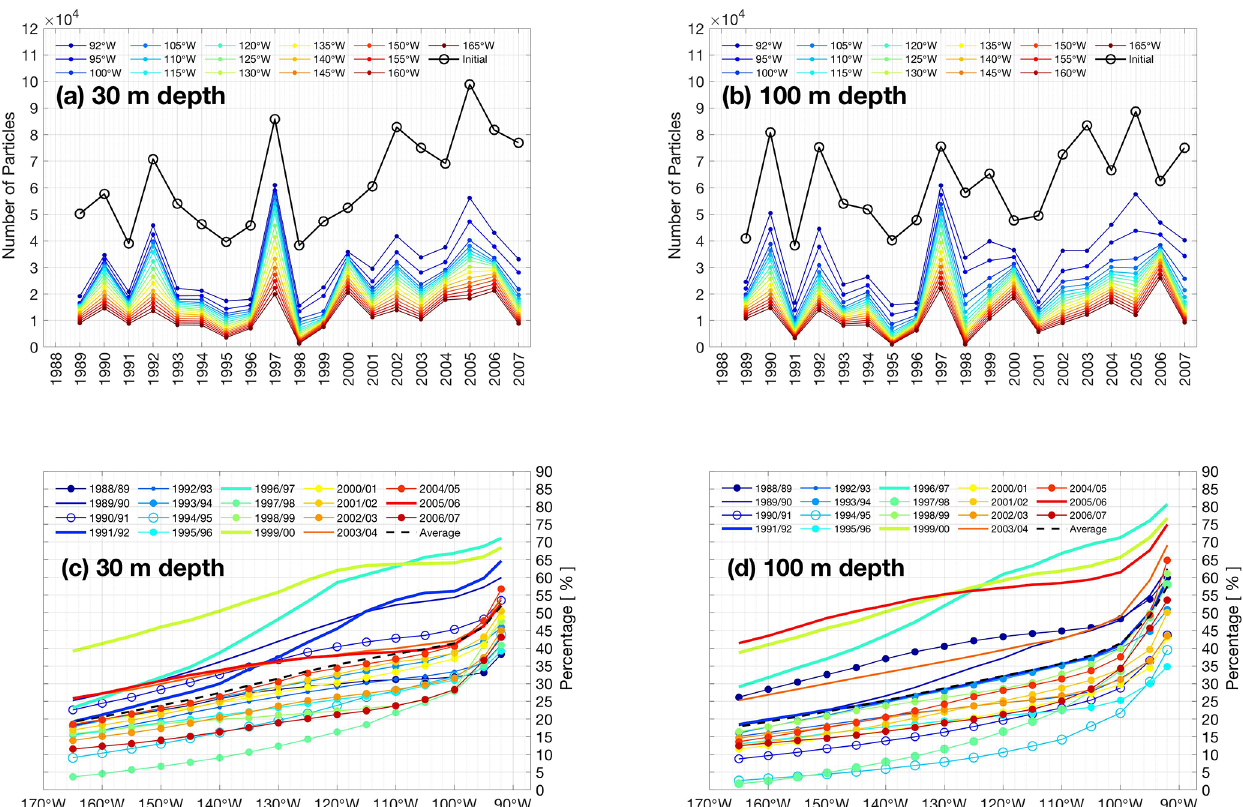
Figure 7. Annual-integrated number (from December–January, monthly releases) of particles and percentage experiments associated to the EUC (3 ◦ N–3 ◦ S) every 5 ◦ from 165 to 95 ◦ W and at 92 ◦ W, for 30m releases in panels (a) and (b) , and for 100m releases in panels (c) and (d) . In panels (a) and (b) , the number of particles per experiment is plotted at calendar-year boundaries. In panels (c) and (d) , particle percentages are labeled by the two calendar years across which currents are